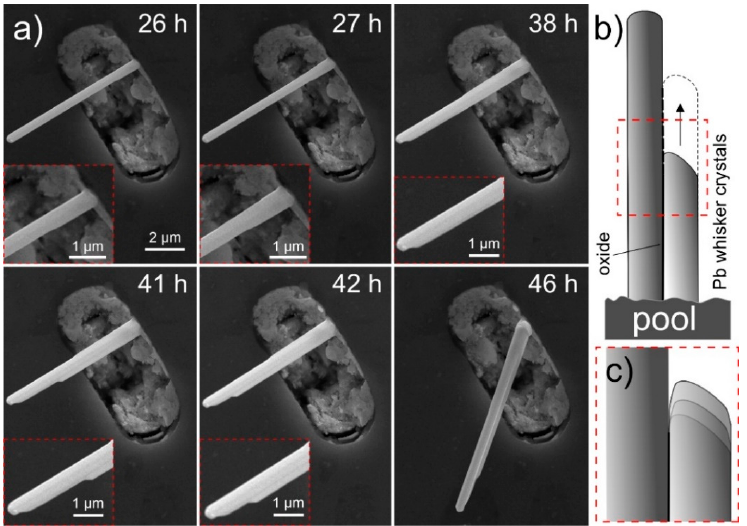
Figure 3. ( a ) Time evolution of whisker widening through growth of additionally activated facets at the side of the main crystal. The individual inserts portray enlargements of sites of interest for comparison of individual images. The timestamp denotes the time from the final polishing of the surface. ( b ) Schematic representation of stepwise whisker growth with ( c ) enlarged portion displaying the incremental growth that corresponds to the serrations found in individual whisker crystals as seen in Figure 2c.